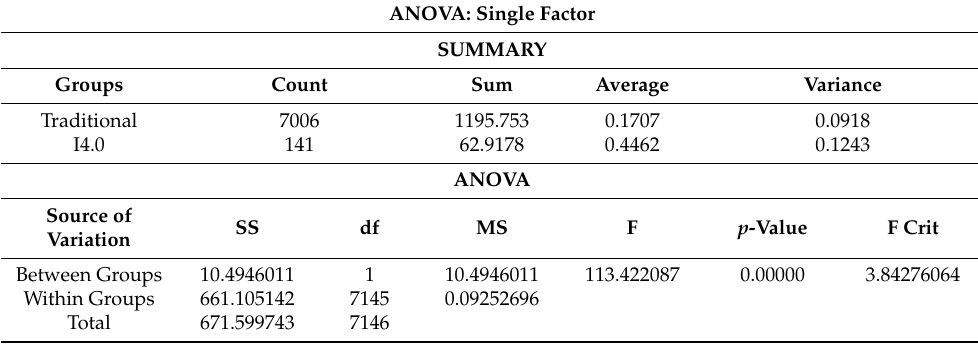
Figure 10 . Distributions of the share of exports in operating income . Table 7 . ANOVA of the share of exports in operating income .